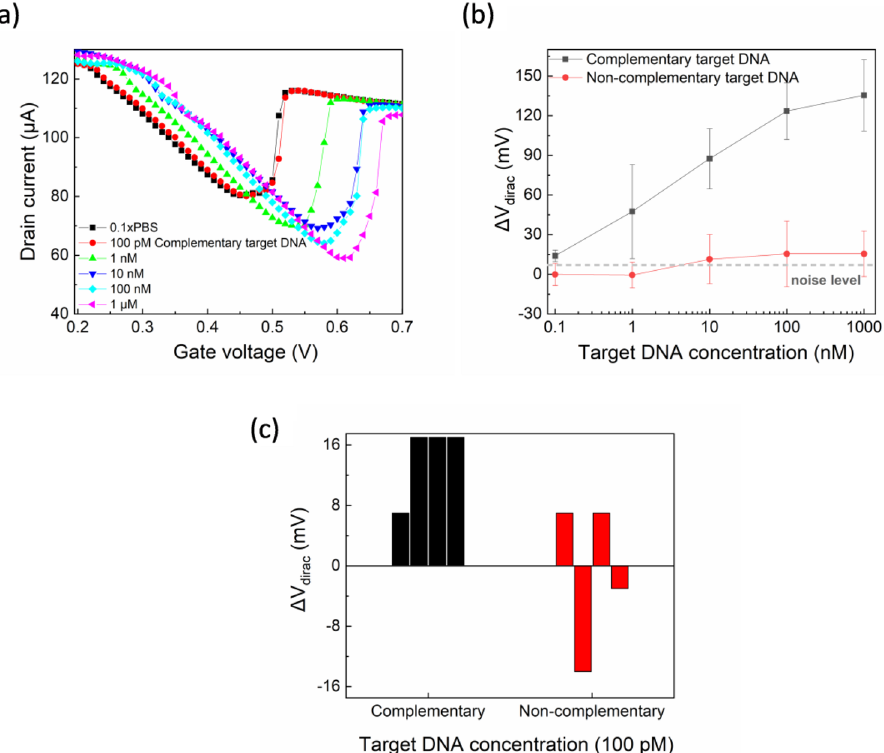
Figure 4. ( a ) Transfer curves for blank (0.1× PBS) and various complementary target DNA concentrations, ( b ) mean values of V Dirac shifts for various complementary and non-complementary target DNA concentrations (bars represent standard deviations of 5 devices for each case), ( c ) high array yield of 8 graphene FETs; ΔV Dirac data for 100 pM hybridization and control.